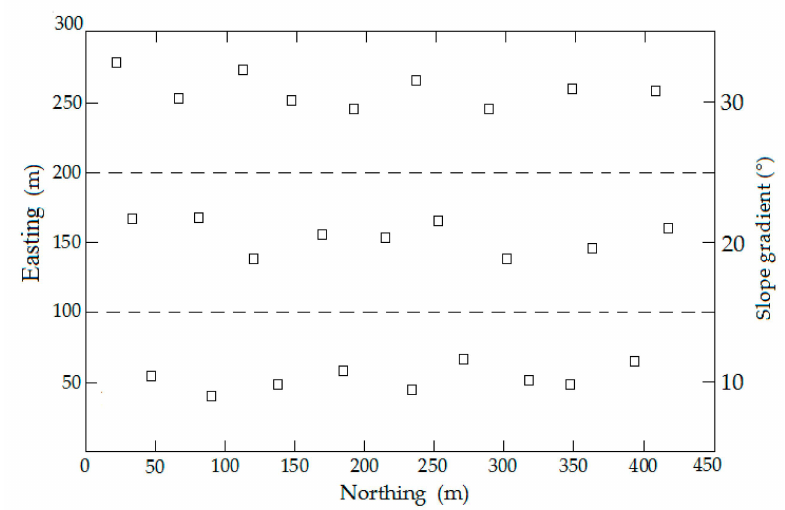
Figure 3. Distribution of sampling plots and their slope gradients.